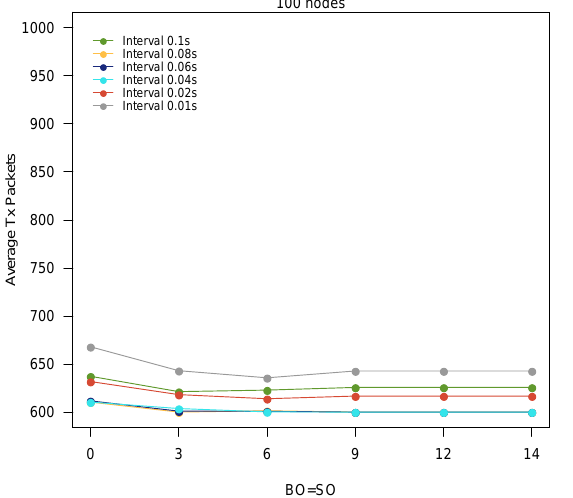
Figure 16. Reduced network Tx packets overhead by increasing the association request